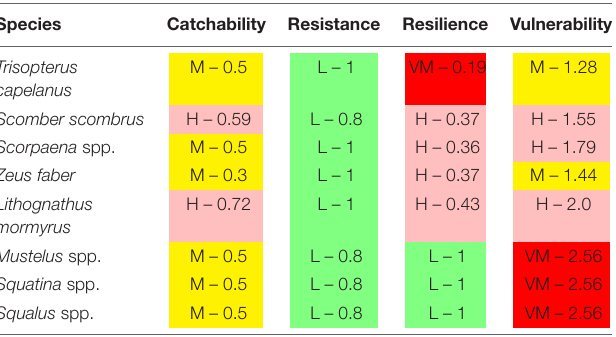
TABLE 4 | Species that characterized historical declines in Mediterranean trawl catches, based on Traditional Ecological Knowledge (Maynou et al., 2011; Damalas et al., 2015), with their vulnerability level and